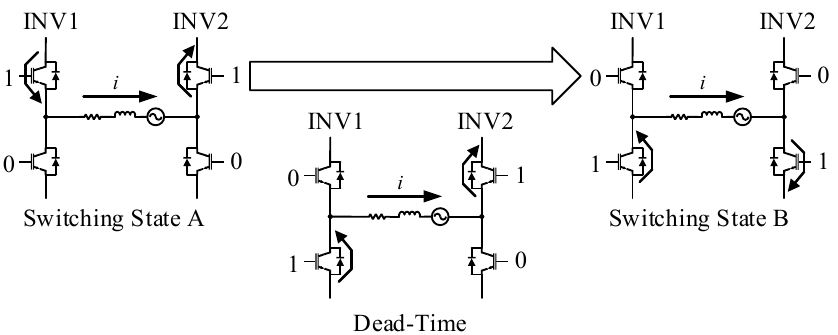
Figure 9. Synchronously switching transitions in same phase of dual inverter motor drive.